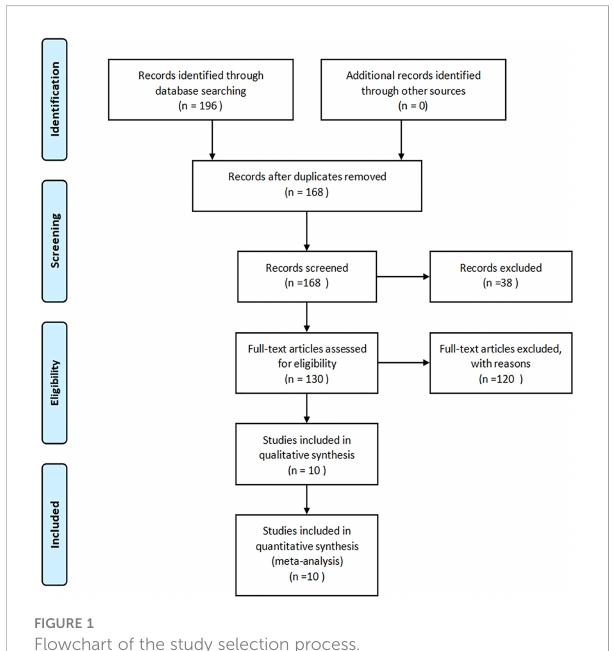
FIGURE 1 Flowchart of the study selection